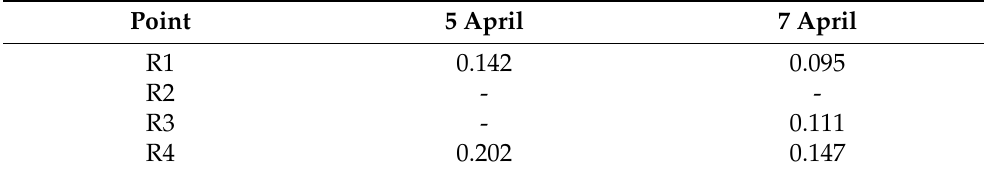
Table 1. Stream discharge during the tracer test [m 3 /s].